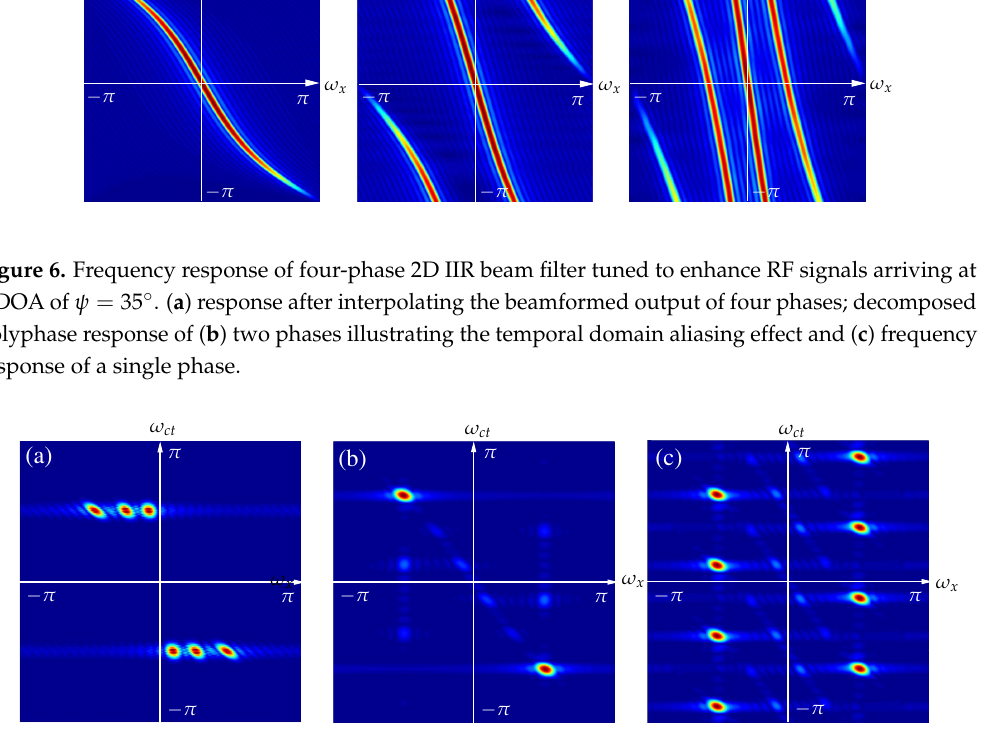
Figure 7. Directional enhancement simulation of the four-phase polyphased 2D IIR beam filter using three Gaussian modulated pulses in frequency domain. ( a ) wideband input signals with DOAs (15 ◦ ,35 ◦ ,70 ◦ ); ( b ) interpolated output signal with directional enhancement and ( c ) decomposed output of one phase with a temporal aliasing effect.